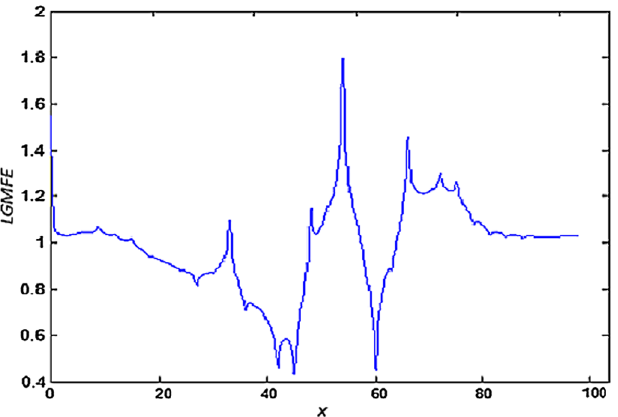
FIG. 6. Flowchart to determine the interface between the normal conducting and superconducting conducting